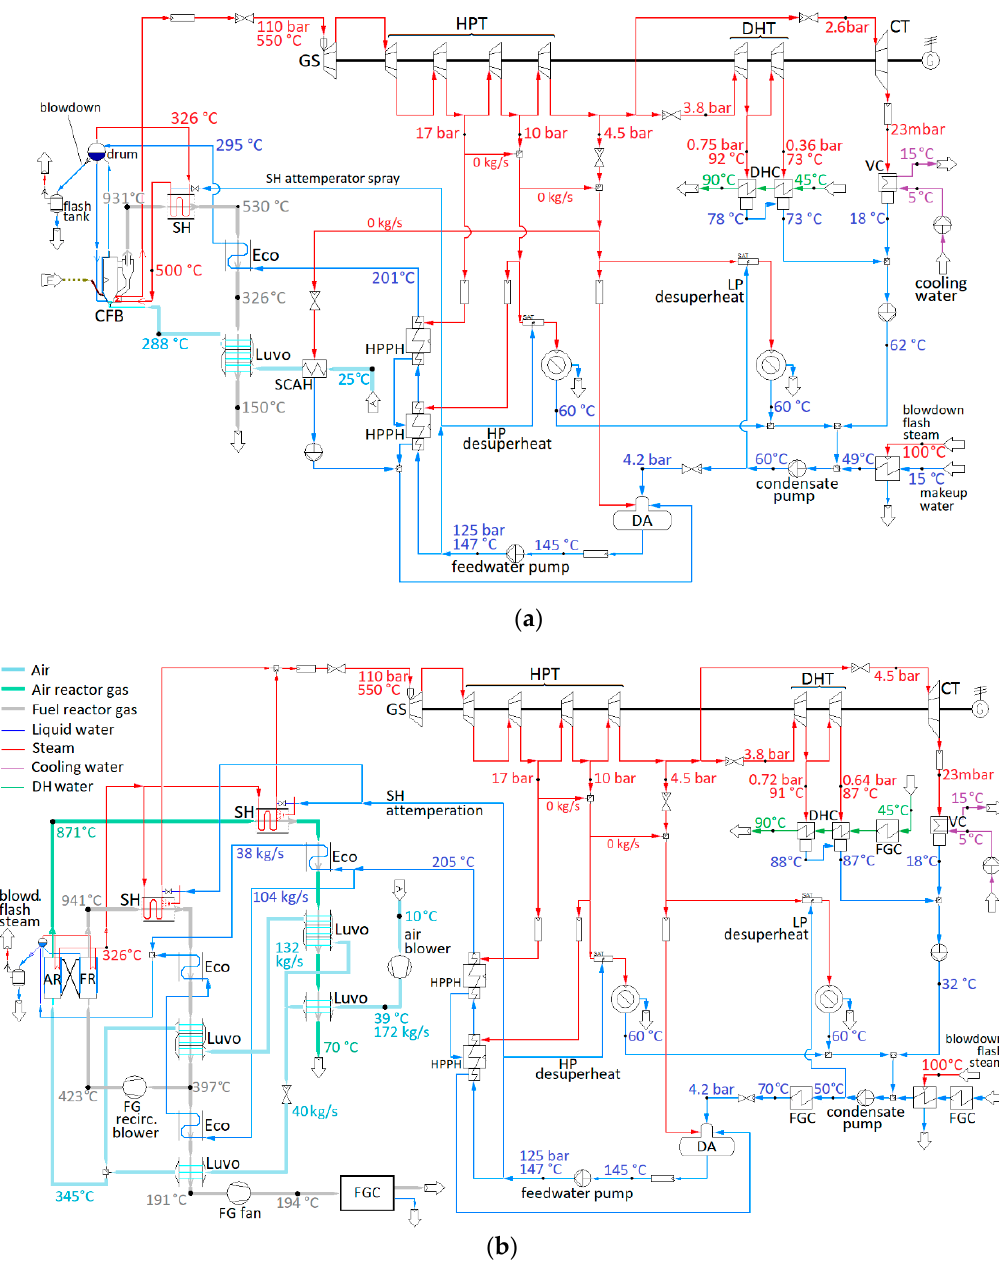
Figure 3. Configurations of: ( a ) the reference plant; and ( b ) the CLOU-CHP plant. Component labels: GS, governing stage; HPT, high pressure turbine; DHT, district heat turbine; CT, condensing turbine; VC, vacuum condenser; DHC, district heat condensers; SH, Superheater; Eco, economizer; Luvo, air heater; SCAH, steam coil air heater; DA, deaerator; HPPH, high pressure feed preheater; FGC, flue gas condensers and the heat exchangers for heat recovery from condensate.